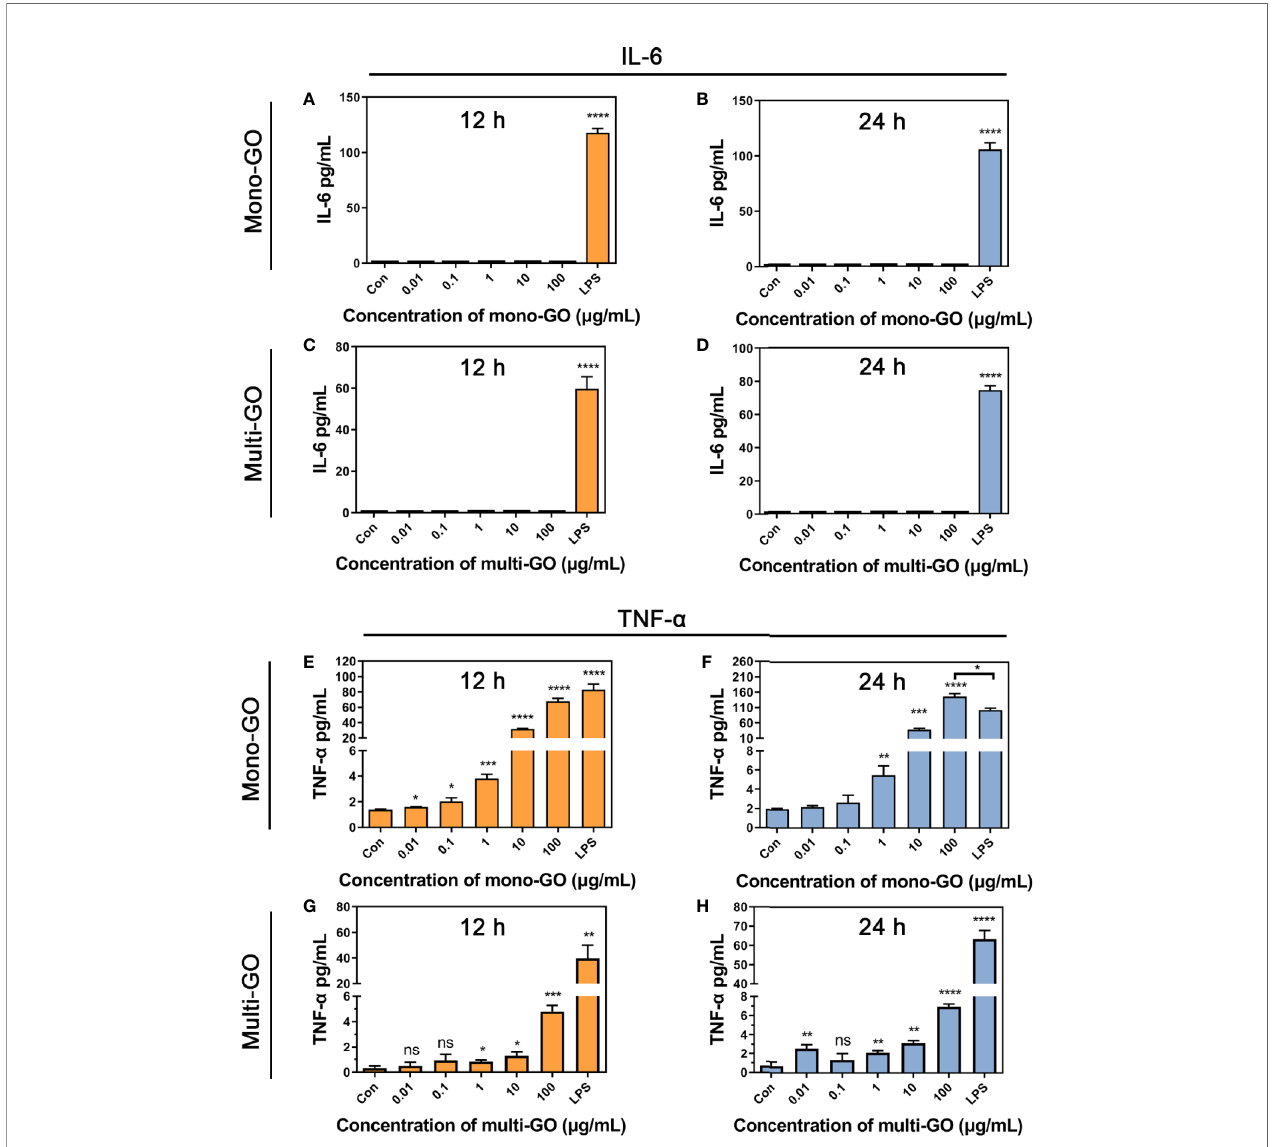
FIGURE 3 | Cytokine secretion of DC2.4 cells exposed to mono – graphene oxide (GO) and multi-GO. (A , B) Cytokine IL-6 secretion from DC2.4 cells after exposure to mono-GO for 12 h and 24 h. (C, D) Cytokine IL-6 secretion from DC2.4 cells after exposure to multi-GO for 12 h and 24 h. (E, F) Cytokine TNF- a secretion from DC2.4 cells after exposure to mono-GO for 12 h and 24 h. (G, H) Cytokine TNF- a secretion from DC2.4 cells after exposure to multi-GO for 12 h and 24 h. (n = 3; * P < 0.05, ** P < 0.01, *** P < 0.001, **** P < 0.0001 vs. Control; ns, no signi fi